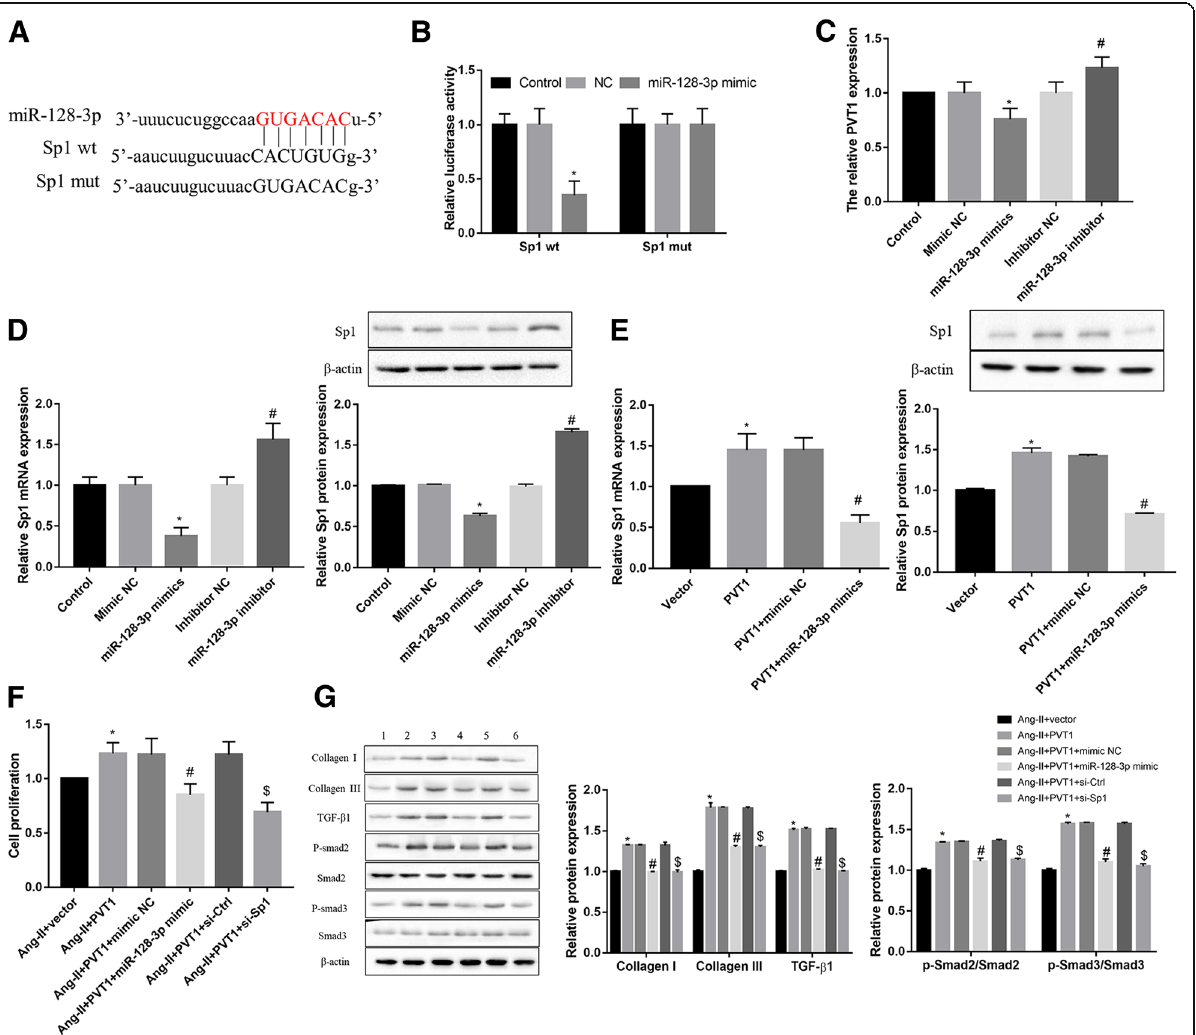
Fig. 4 PVT1 promotes atrial fibrosis by regulating the TGF- β 1/Smad signaling pathway via the miR-128-3p/Sp1 axis. a The predicted binding site between miR-128-3p and 3 ′ -UTR of Sp1 (Targetscan). b Luciferase assay confirmed that Sp1 was a target of miR-128-3p. miR-128-3p mimic significantly suppressed PVT1 expression ( c ), and the mRNA and protein expression of Sp1 ( d ). miR-128-3p inhibitor exerted the opposite effect. e miR-128-3p mimic significantly reversed the PVT1 overexpression-induced Sp1 expression, at both mRNA and protein levels. Effect of miR-128-3p mimic and Sp1 silencing on the PVT1 overexpression-induced fibroblasts proliferation ( f ), collagen production, and TGF- β 1/Smad signaling activation ( g ) was shown. b * P < 0.05 vs. Sp1 wt + mimic NC; (C-D) * P < 0.05 vs. mimic NC, # P < 0.05 vs. inhibitor NC; ( e ) * P < 0.05 vs. vector, # P